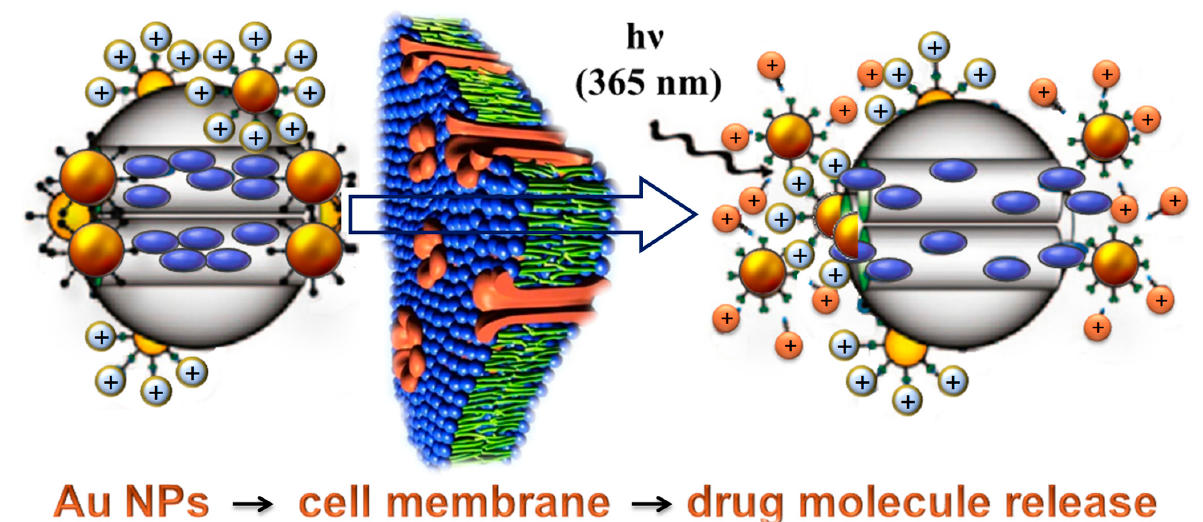
Figure 1. Schematic illustration of the photo-induced intracellular controlled release of gold nan- ospheres. Upon UV irradiation, the photo-labile linker on the gold NPs is cleaved, changing the surface charge of gold NPs from positive to negative. The charge repulsion between the gold NPs then uncaps the mesopores and allows the release of the drugs for cancer therapy